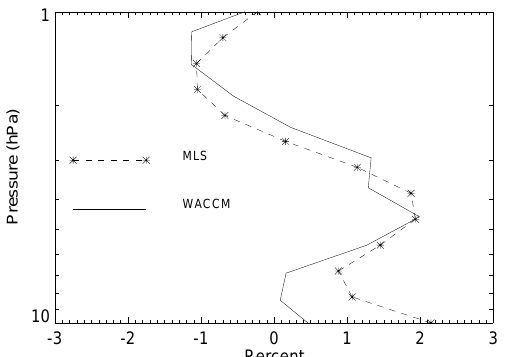
Figure 8. Percent change in monthly averaged ozone for June 2009 minus June 2008 at 75 ◦ N. The solid line is from WACCM/NOGAPS and the dashed line with stars is from MLS data.